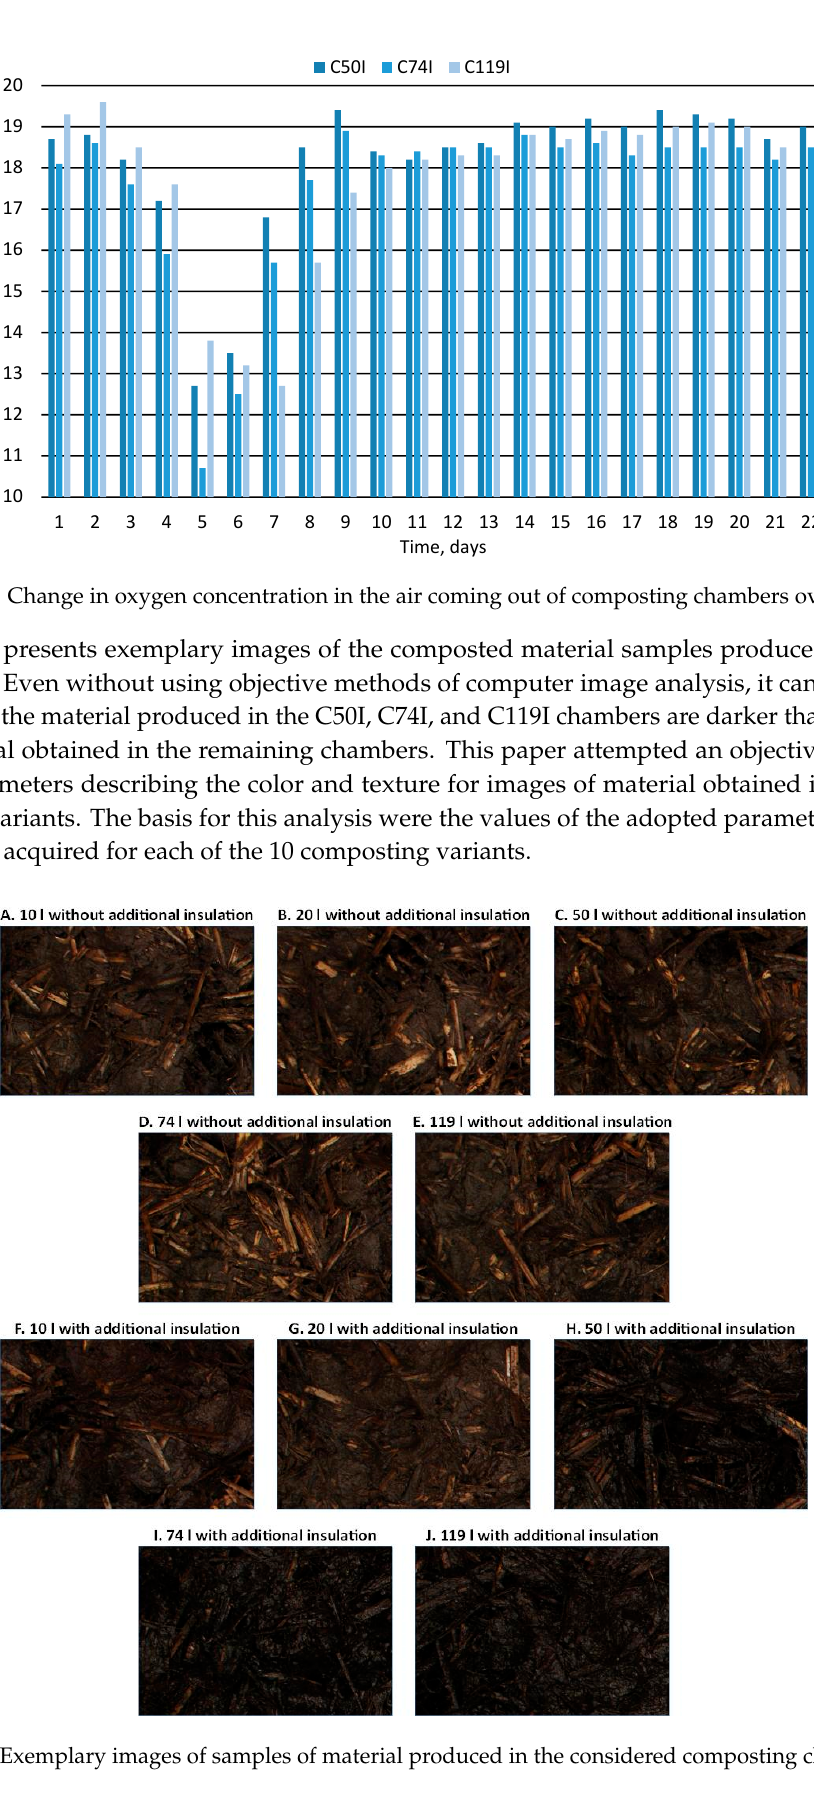
Figure 2. Change of composted material temperature over time.